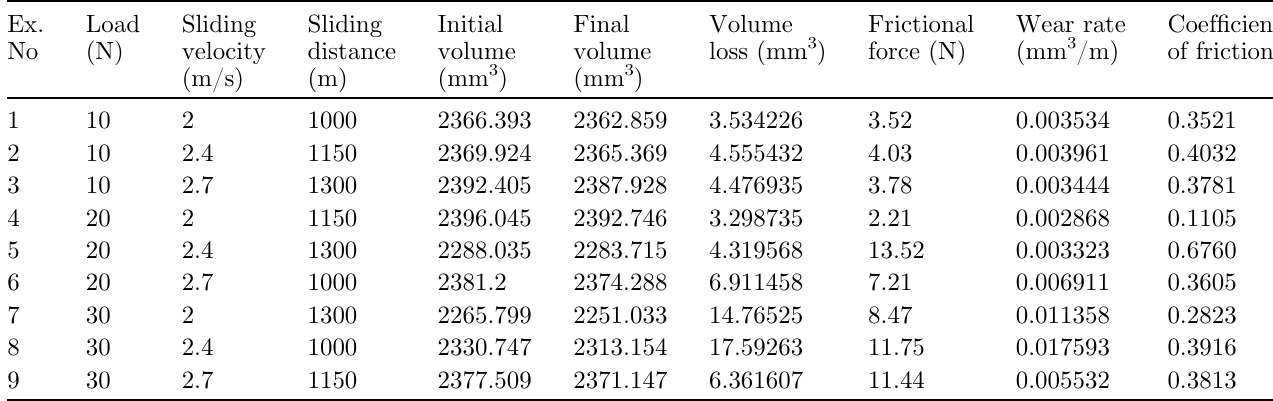
Table 4. Wear rate and coef fi cient of